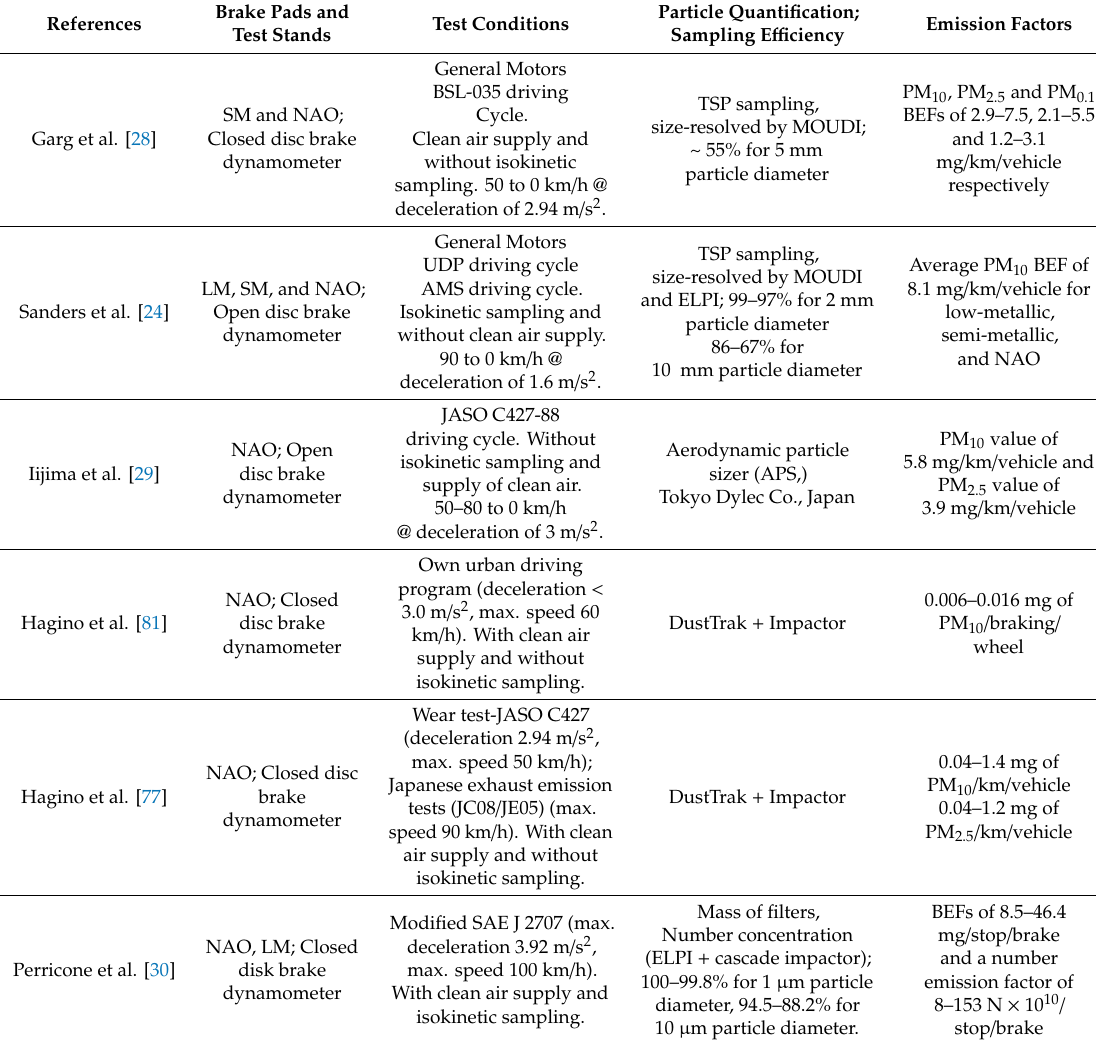
Table 3. Overview of selected dynamometer studies